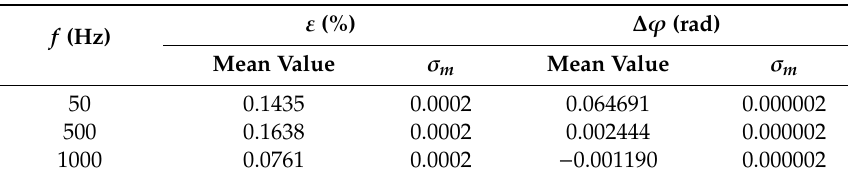
Table 3. Experimental SF test results.